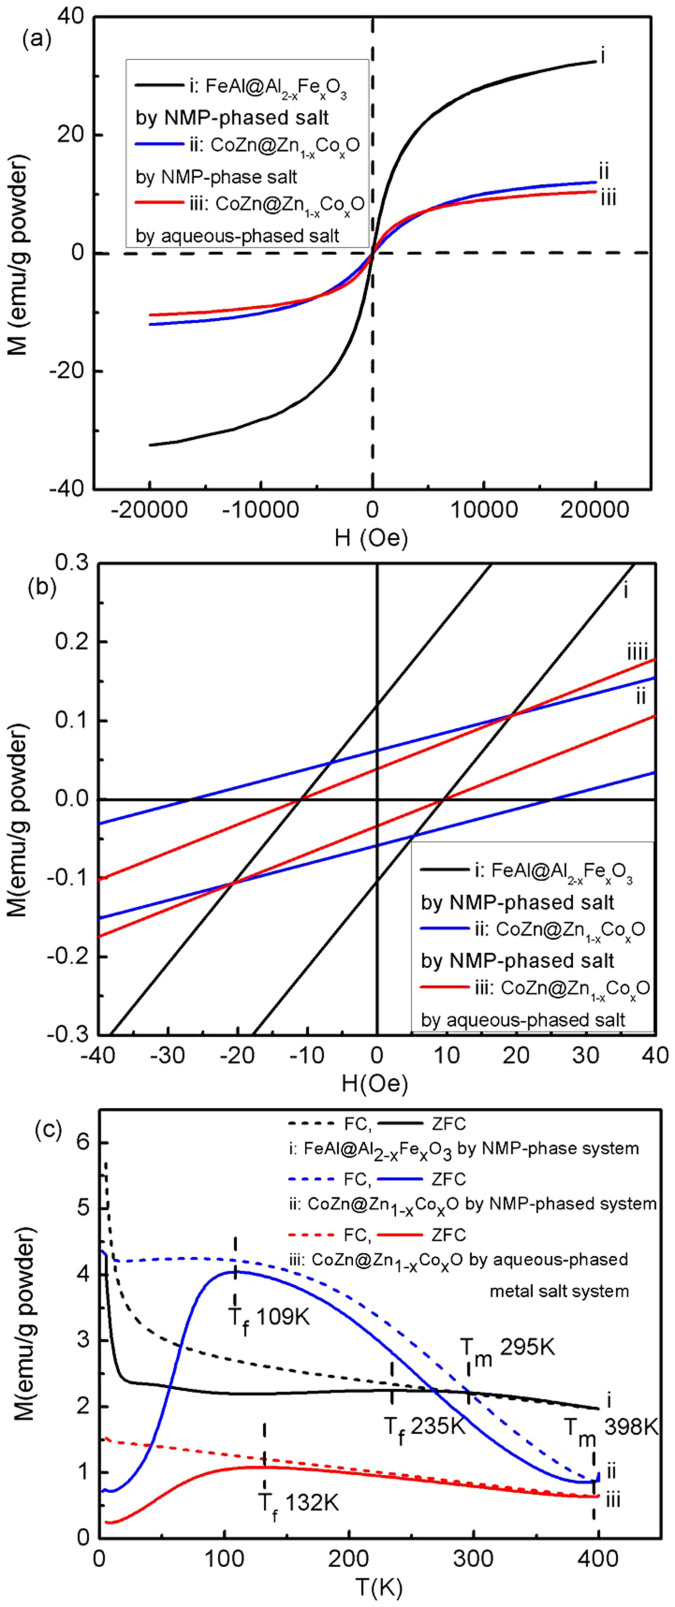
Full-range (a) and magnified-center (b) of room temperature hysteresis loop and the thermo-magnetism curves (c) (ZFC: zero-field cooling; FC: field cooling) of (i) FeAl@Al(1-x)FexOy and (ii) CoZn@Zn(1-x)CoxOy nanohybrids synthesized using all NMP-phased reaction systems and (iii) CoZn@Zn(1-x)CoxOy nanohybrids synthesized using aqueous-phase metal salt reaction systems.